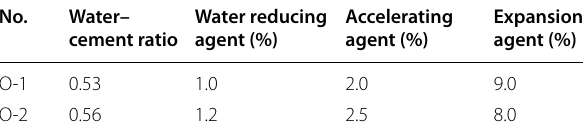
Table 8 Formula of the cement grouting material based on the orthogonal